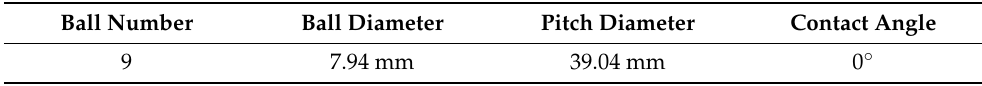
Figure 13. The local machinery fault simulator: ( a ) The experimental fault simulation operation platform; ( b ) signal acquisition display; ( c ) acceleration sensor locations; ( d ) outer race fault bearing; ( e ) inner race fault bearing. Table 2. Parameters of the SKF6205 bearing.